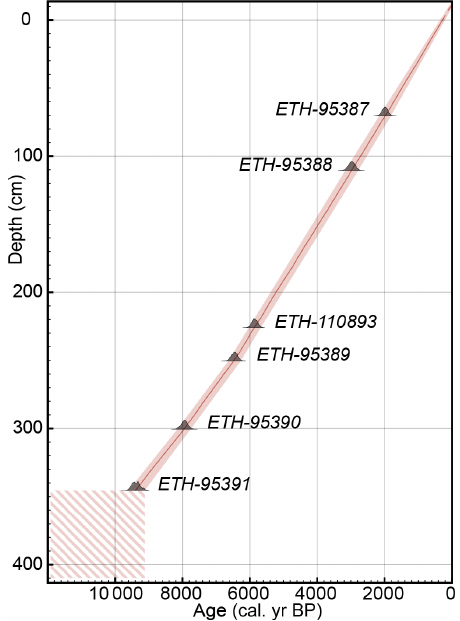
Figure 4. Age–depth model of core DA17-NG-ST07-73G based on six AMS 14 C dates and on the comparison with Rumohr core DA17-NG-ST7-72R. The shaded area around the line illustrates the 2-sigma uncertainty range of the model. The hatched box in the bot- tom of the core indicates an interval containing many reworked mi- crofossils, which is therefore still of uncertain age (see pink shading in Fig.